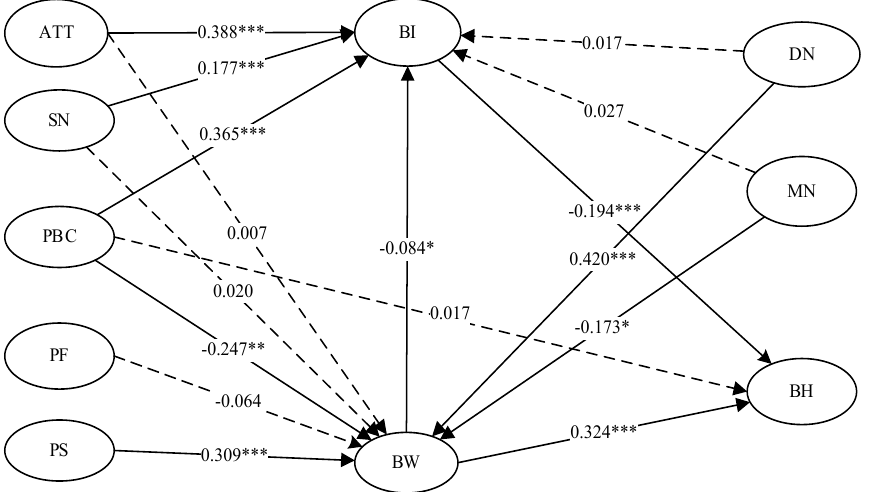
Figure 1. The pathway of the integrated model, * p < 0.05, ** p < 0.01, *** p < 0.001.